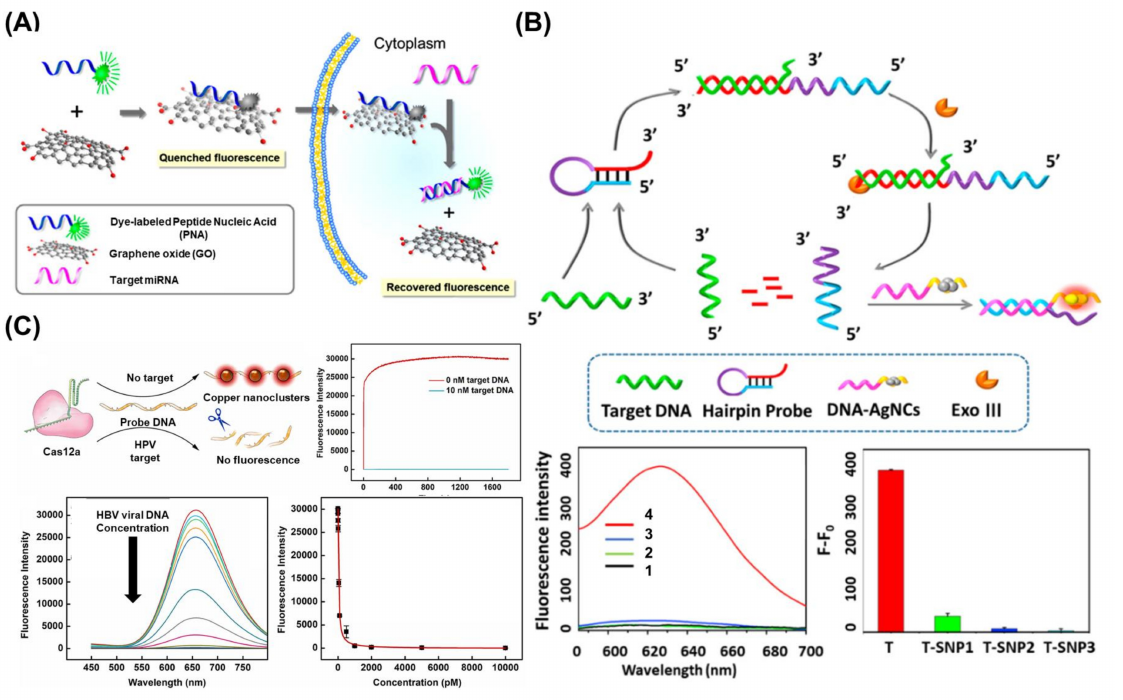
Figure 5. ( A ) Schematic illustration of PANGO-based fluorescent biosensor for detection of miRNAs in living cells. Reprinted with permission from Ref. [110]. Copyright © 2013, American Chemical Society. ( B ) Schematic diagram of biosensing mechanism of fluorescent biosensor composed of DNA-AgNCs, the G-rich hairpin probe and Exo III for detection of HIV-1 DNA, the